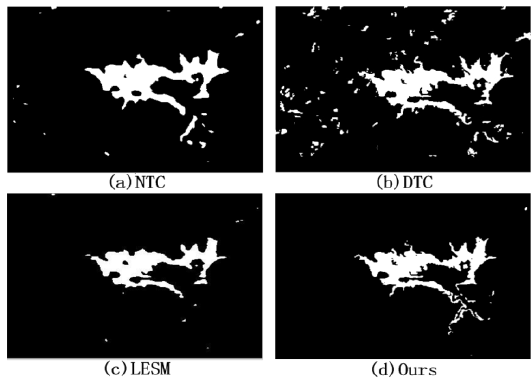
Figure 5: Visual comparison on Sardinia